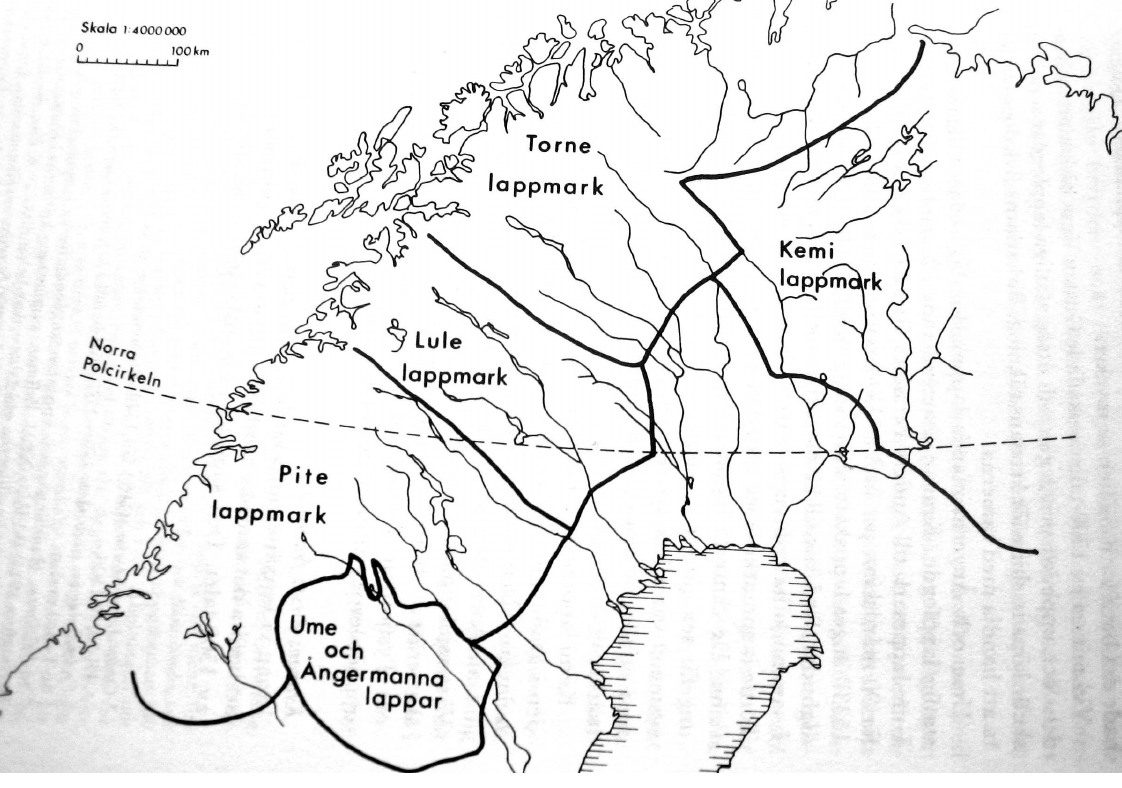
Fig. 1. The areas covered by the Swedish king’s registers for tax and fur-trade